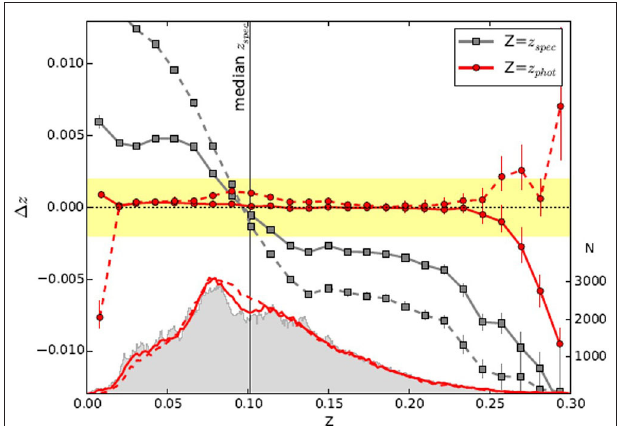
FIGURE 10 | Figure from Pasquet et al. (2019). The bias as a function of both spectroscopic (gray) and photometric redshifts predicted by the CNN (red), with the corresponding redshift distributions and the comparison of results with that of Beck et al. (2016). The yellow shaded zone represents the requirement for Euclid ( 1 z ≤ 0.002) in photometric redshift